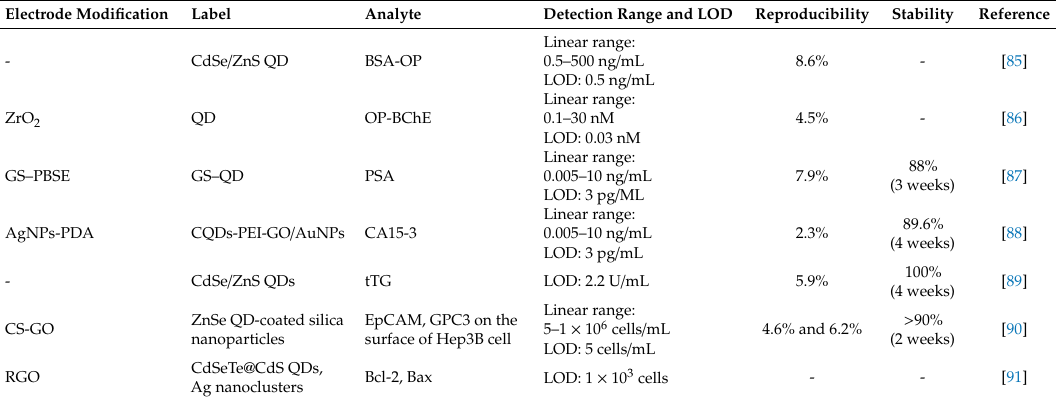
Table 3. Quantum dot (QD) Nanomaterials for electrochemical immunosensors. Electrode Modification Label